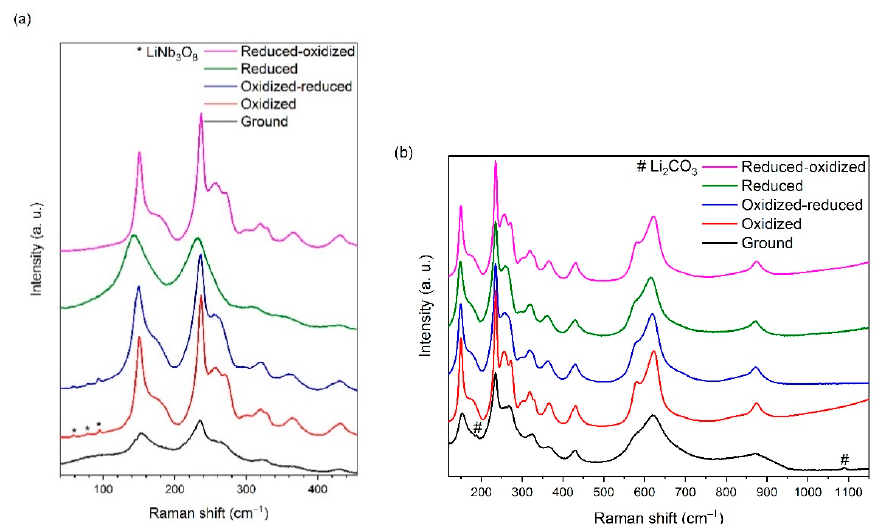
Figure 3. Raman spectra of ground and heat-treated samples ball-milled for five hours in stainless steel vial, shown in the range of 40–460 cm –1 ( a ), and in tungsten carbide vial, shown between